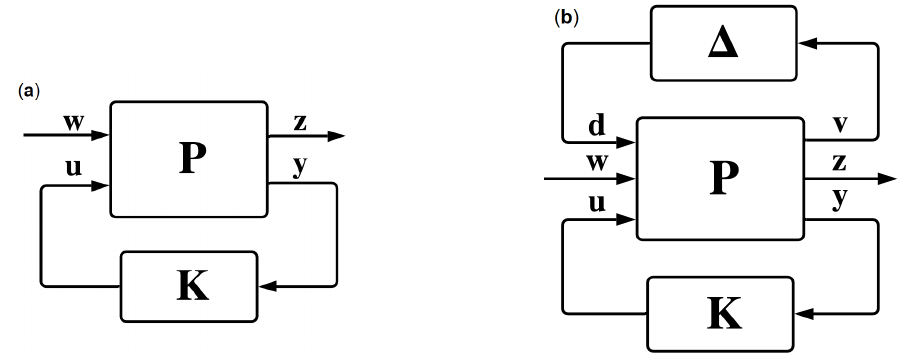
Figure 5. ( a ) Generalized plant framework; ( b ) generalized plant framework with